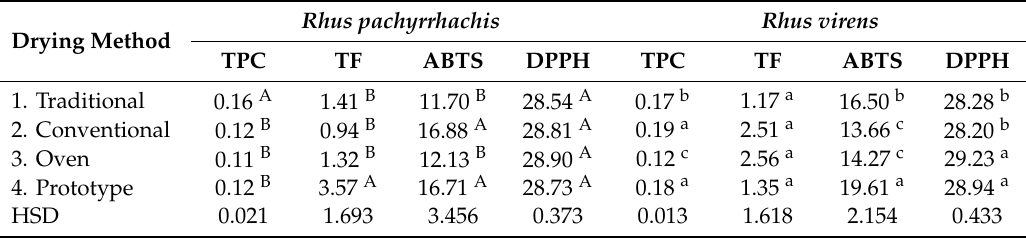
Table 2. Comparison of means between four drying methods for total phenolic content (TPC, mg GAE / g of DW), contents of total flavonoid (TF, mg Q / g DW), and free radical-scavenging capacity